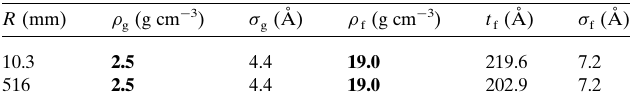
Table 1 Results of the fit of the XRR on Sample 1 and Sample 2. Parameters in bold were fixed during the fit.